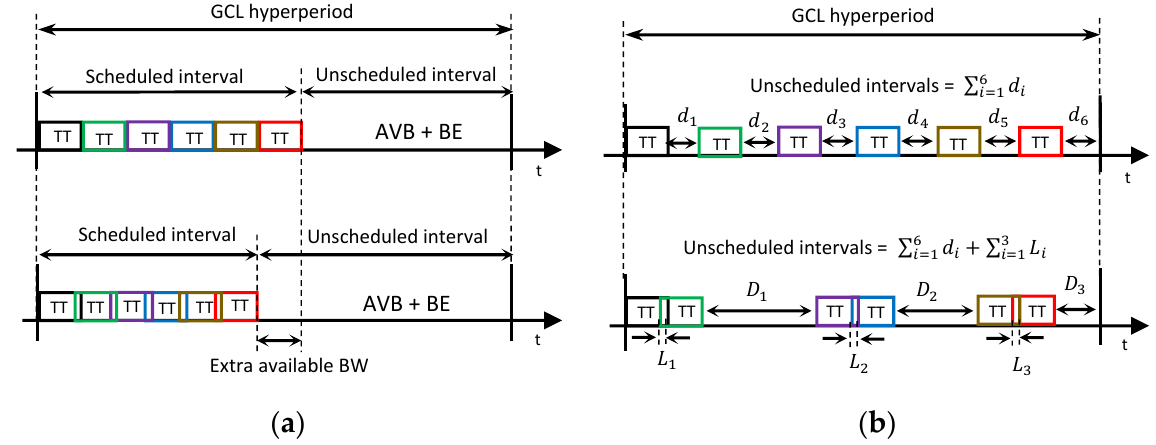
Figure 3. Configurations of the time-triggered (TT) schedule under both full isolated windows and flexible overlapping windows: ( a ) back-to-back configuration and ( b ) porosity configuration.